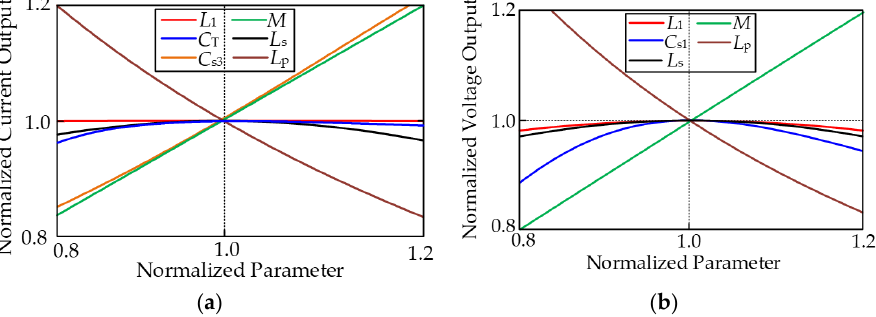
Figure 13. The curves of G v ( f ) and G i ( f ) versus driving frequency.